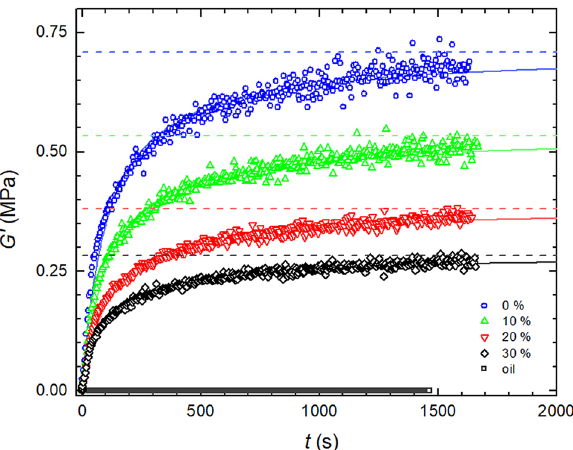
Figure 5. The effect of oil addition on curing kinetics and conversion values of Sylgard 184 (cured at 120 °C).